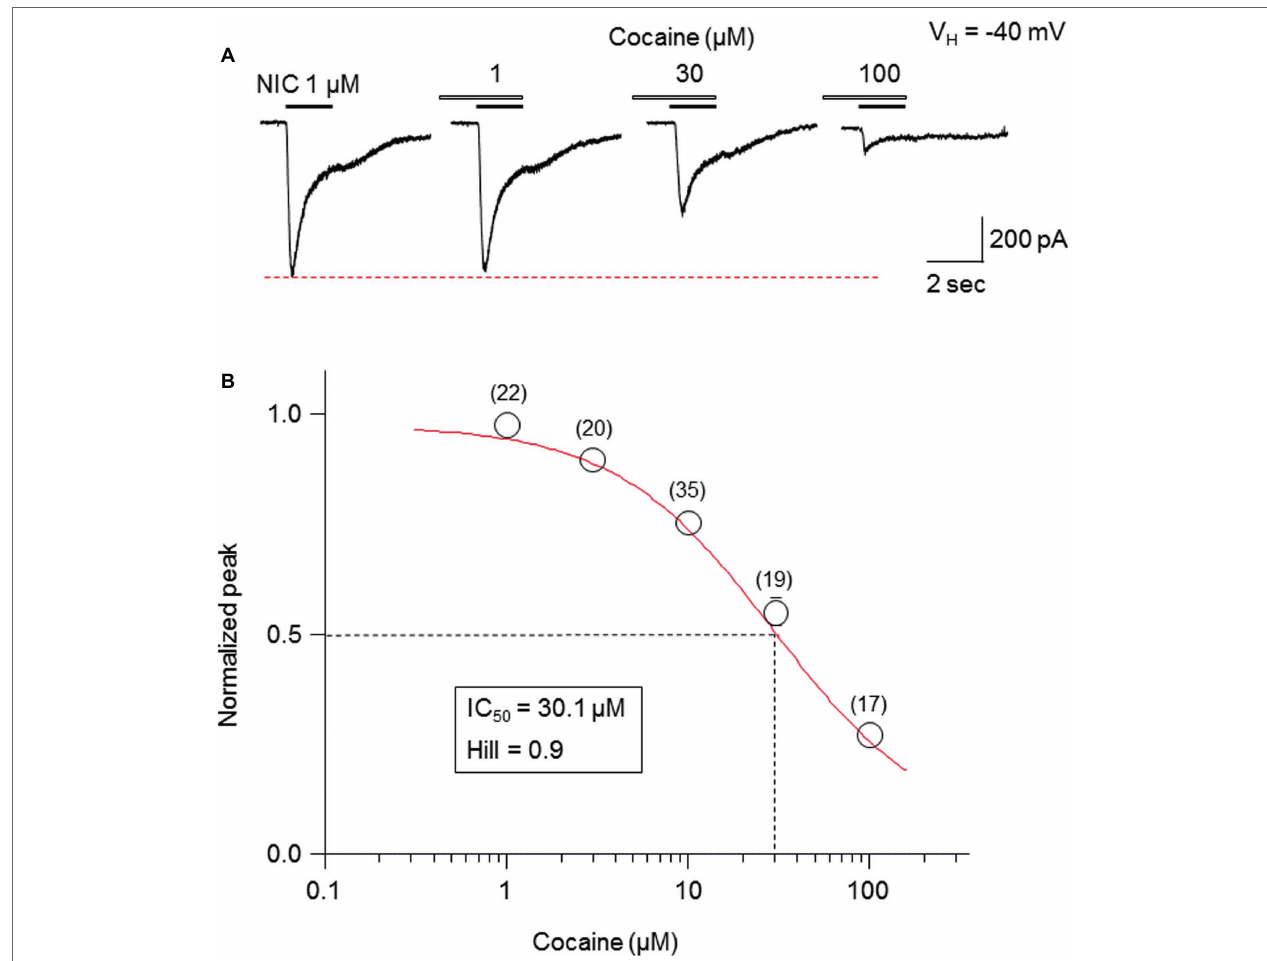
FIGURE 2 | Cocaine inhibits α 6*-nAChR-mediated currents in a concentration-dependent manner. (A) Representative traces showing the inhibition of NIC-induced currents with different concentrations of cocaine. (B) The concentration-inhibition relationship curve from 17 to 35 cells tested (indicated above each symbol) showed a sigmoidal shaped, inhibitory curve of cocaine on NIC response (peak